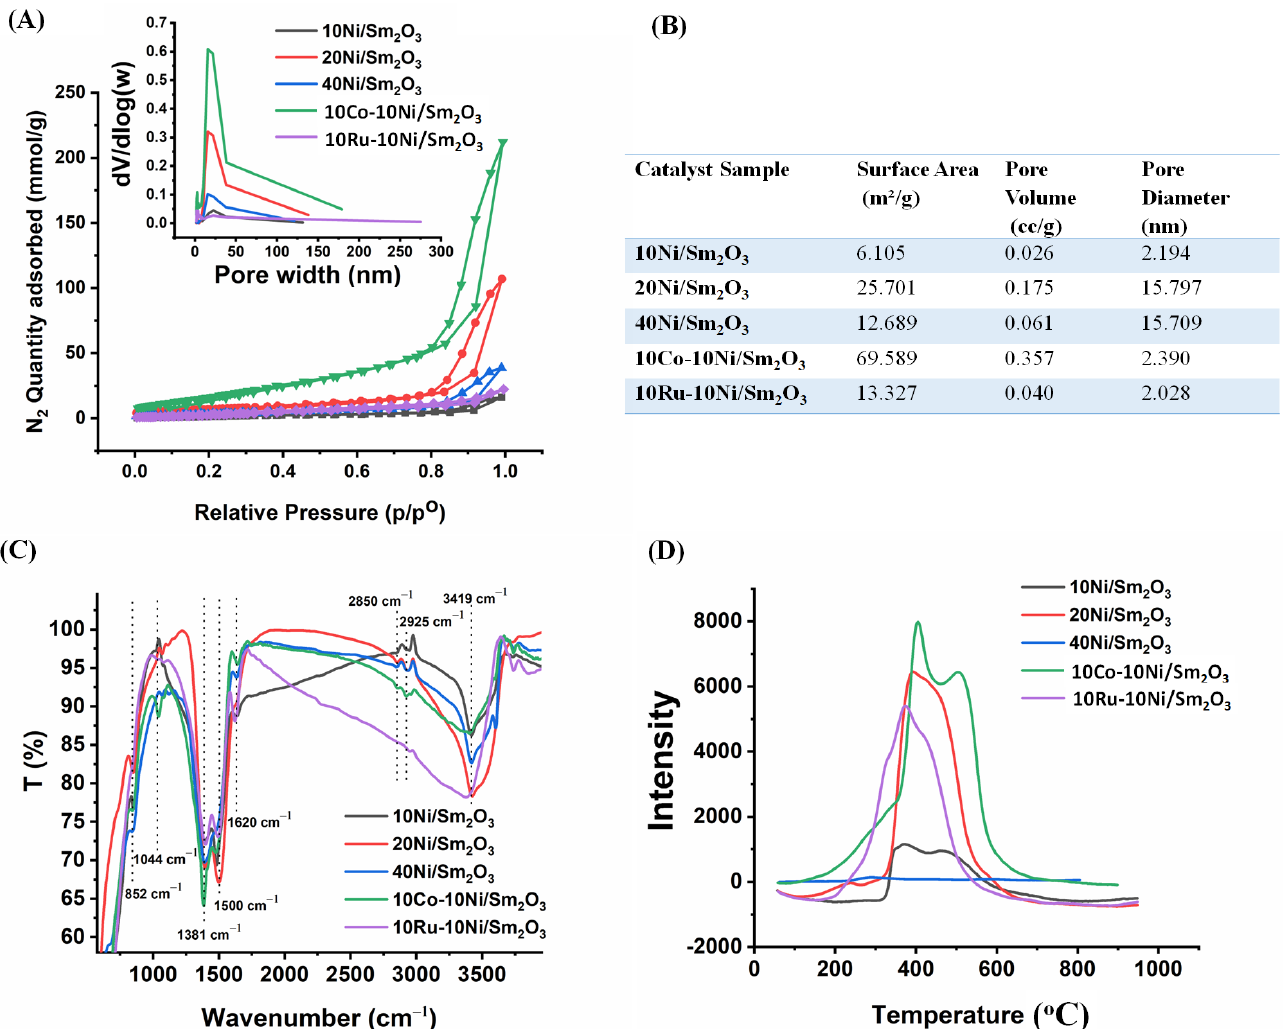
Figure 3. ( A ) N 2 adsorption isotherms of the prepared catalysts ( B ) Table indicating the surface area, pore volume, and pore diameter of the different catalysts ( C ) Infrared transmittance spectra of the different catalysts ( D ) H 2 -temperature programmed reduction profiles of the different catalysts.